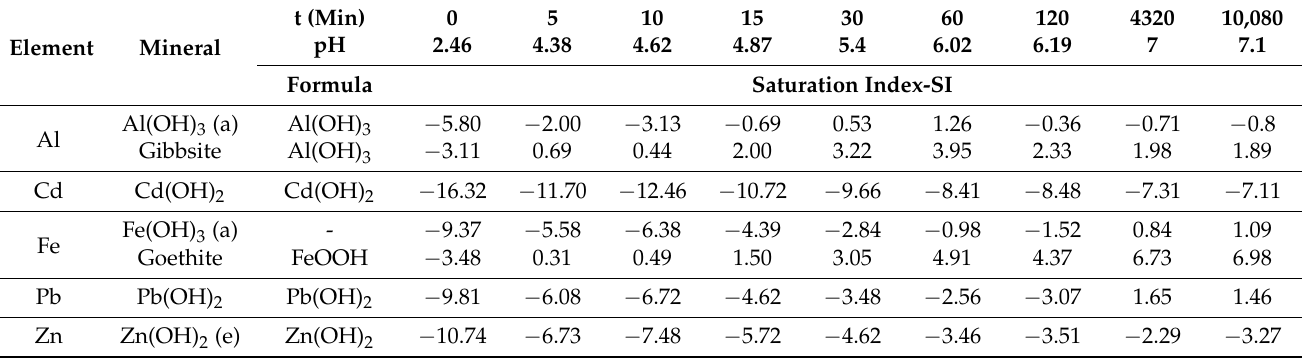
Table 6. Results of the PHREEQC software simulation in the case with EF as a neutralization agent.